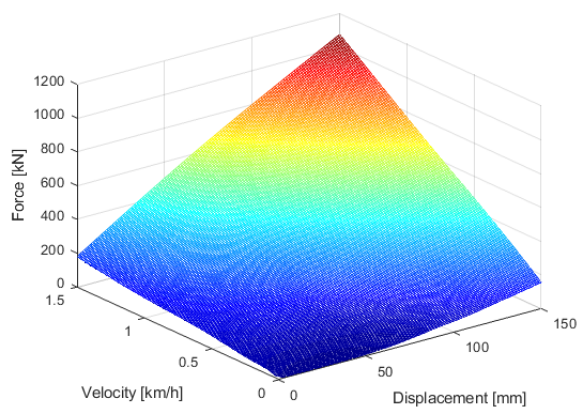
Figure 18. Hydraulic buffer model.